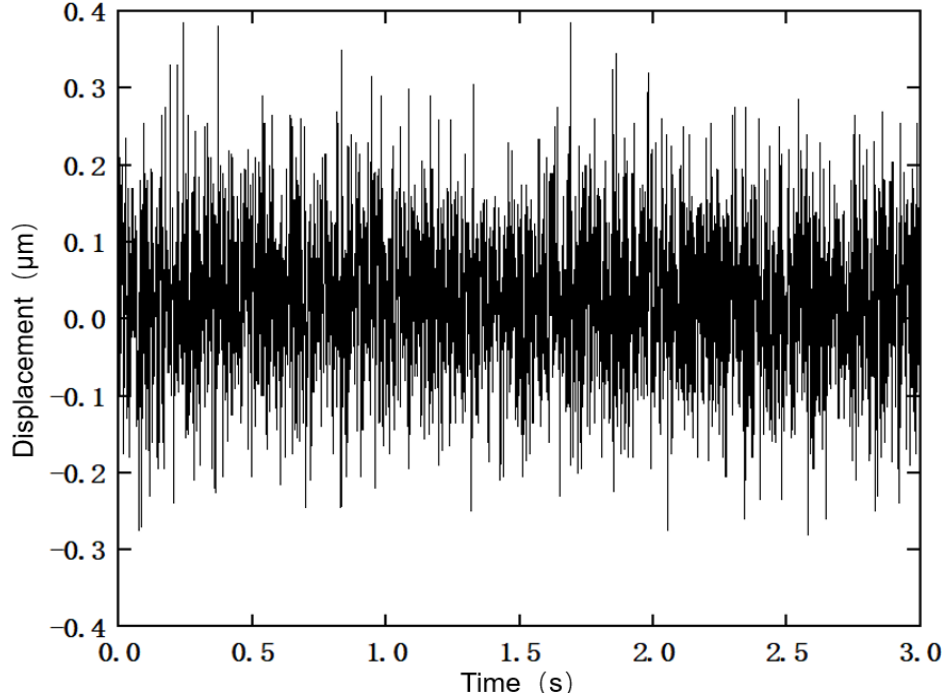
Figure 21. Displacement error diagram caused by external factors.